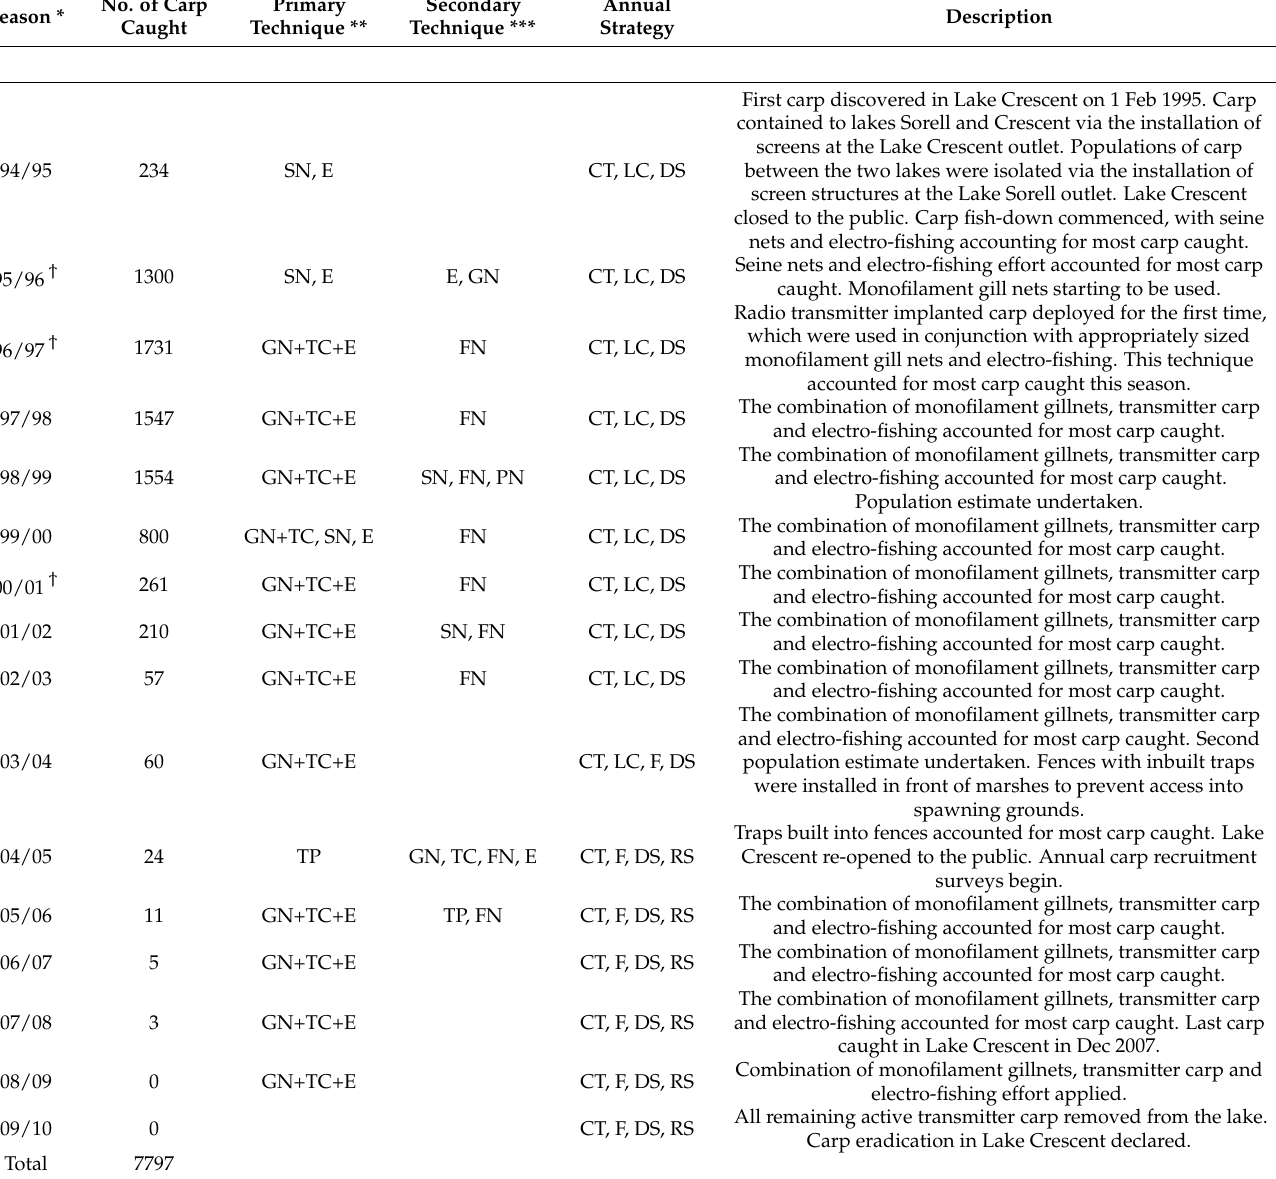
—Indicates a spawning event.